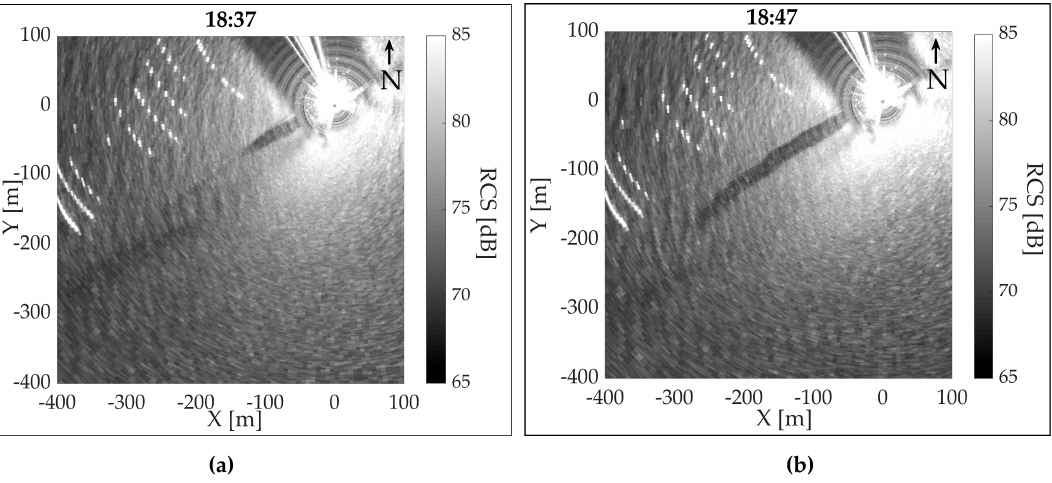
Figure 6. The formation of the band on the radar snapshots at different times: ( a ) 18:37, ( b ) 18:47. The process of formation of the slick band with a visible length of more than 400 m lasted a little longer than 20 min. The band was recorded visually and by the radar. The trajectory of the downwind slick band edge was retrieved from sequential radar snapshots. The obtained trajectory is presented in Figure 7.